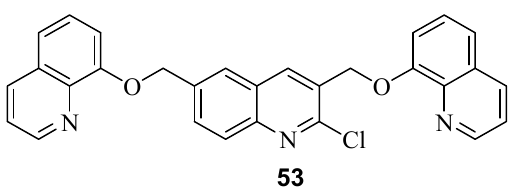
Figure 4. Chemical structure of a 3-quinoline-based molecule.